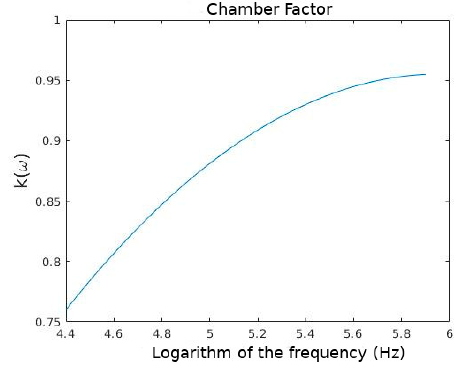
Figure 2. Frequency logarithm against k( ω ).